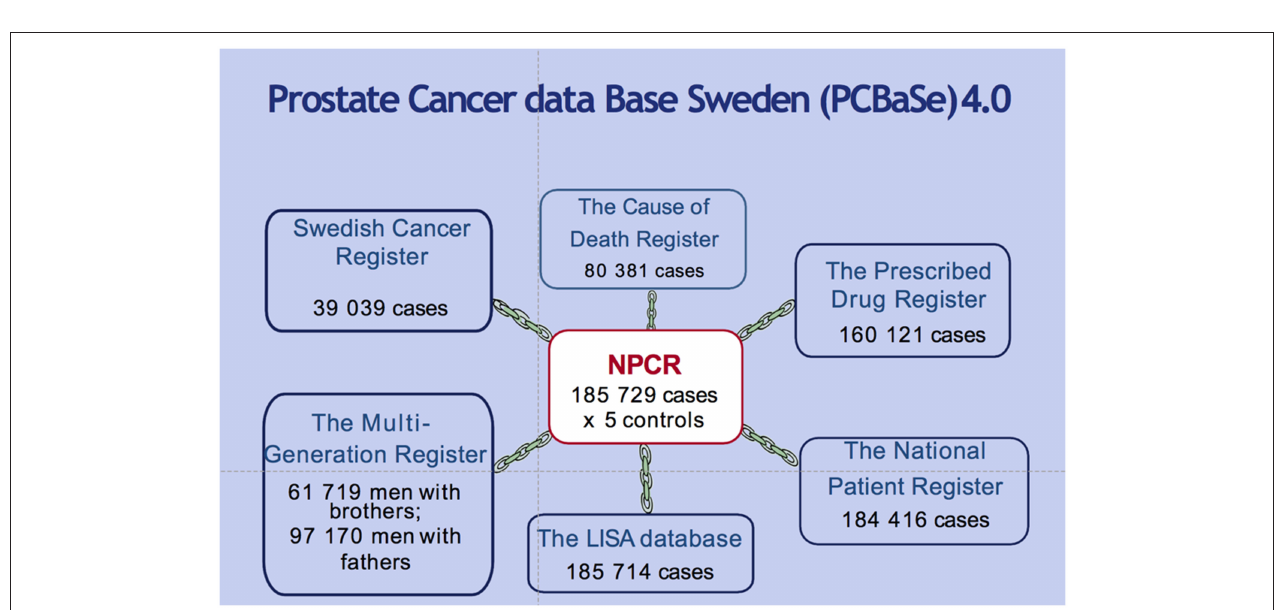
FIGURE 2 | Linkages and number of cross-linked men in the Prostate Cancer Database Sweden (PCBaSe) 4.0. The inclusion criteria for NPCR are applied for all those sub